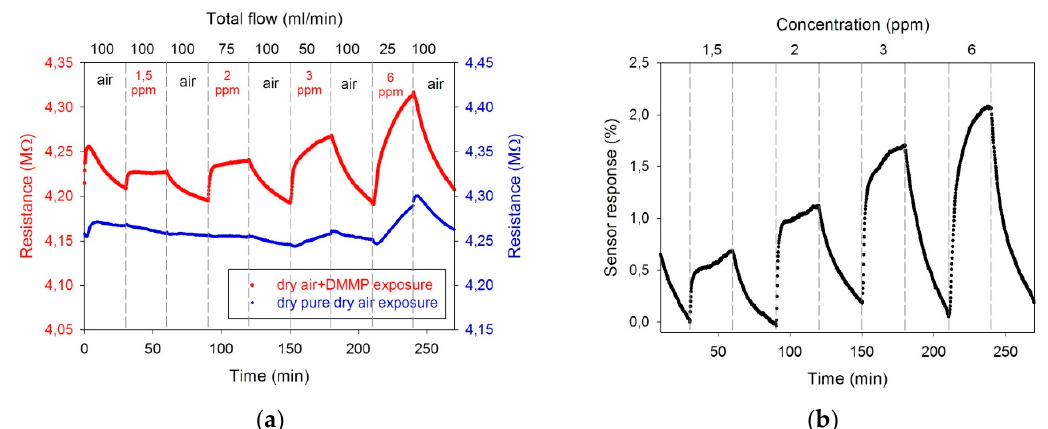
Figure 1. ( a ) Electrical response of studied sensor to the DMMP/air mixture (red curve) and to the pure air (blue curve), ( b ) Sensor response to the different concentrations of DMMP.